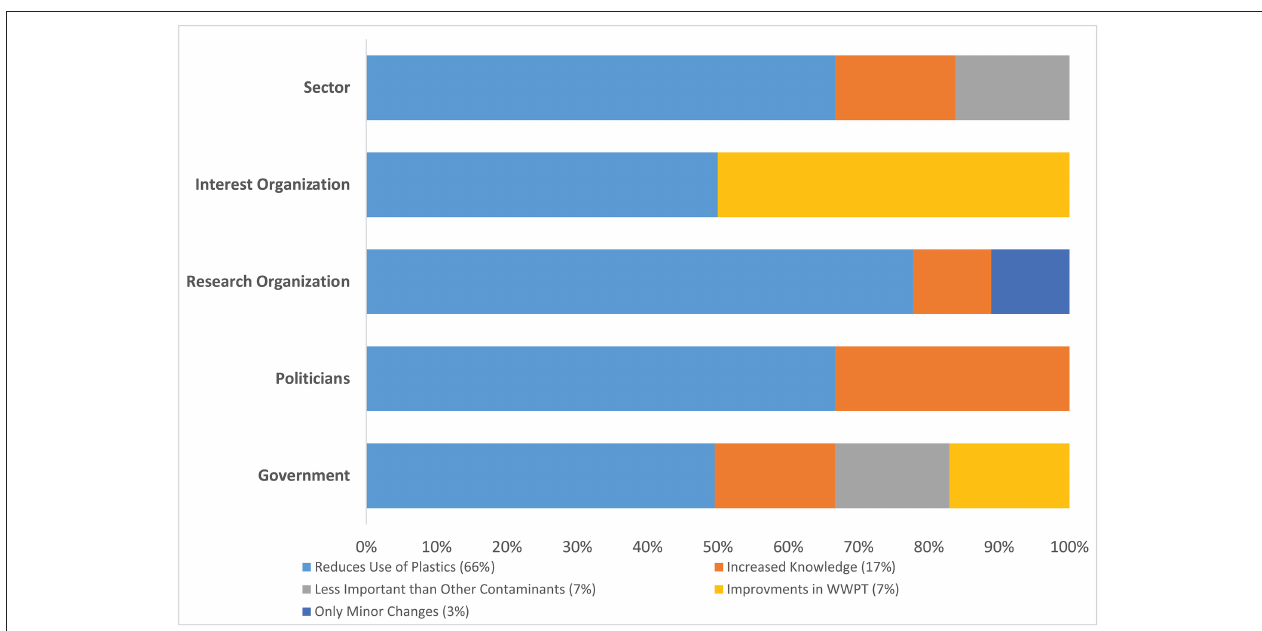
FIGURE 9 | “How do you think MPs in the sludge will look in twenty years from now?” By category of stakeholder. Percentages reported represent the frequency with which an issue was mentioned across all stakeholders responding ( n =